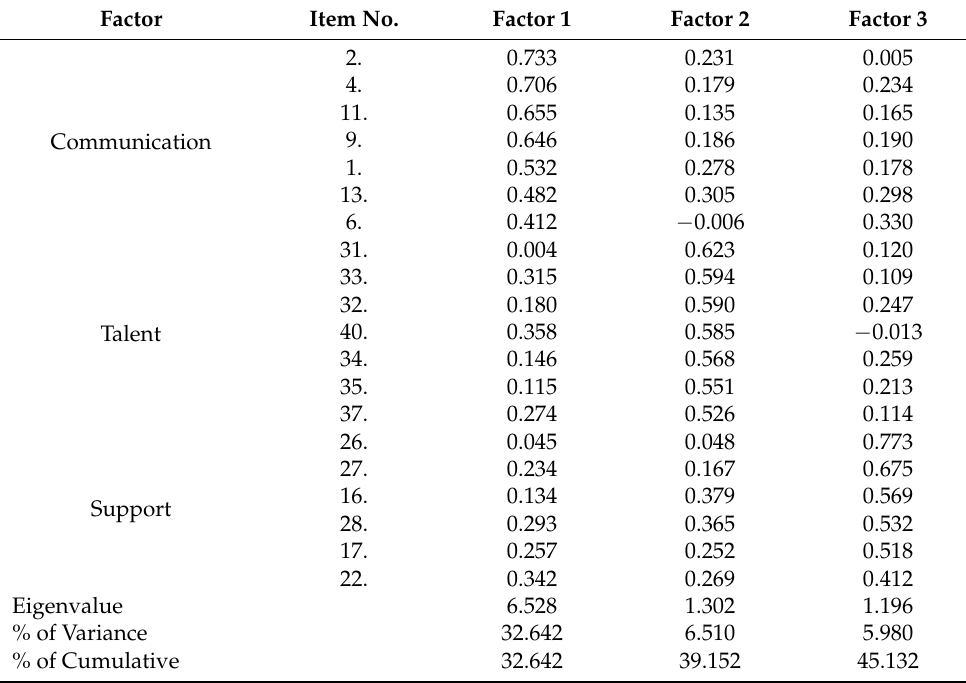
Table 2. Exploratory factor analysis of coach–parent